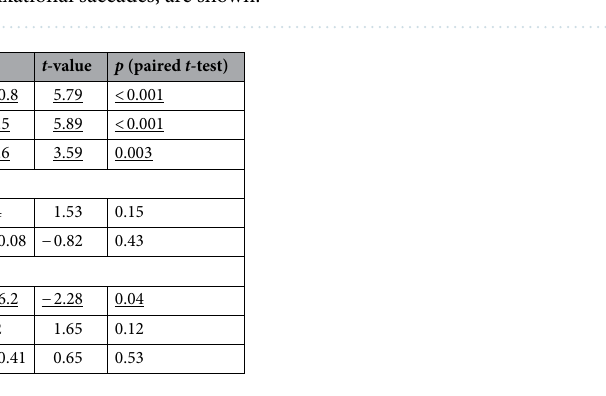
Figure 1. Traces of visually guided saccade, anti-saccade, and fixational saccade. Traces during baseline (top, a – c ) and rTMS (bottom, d – f ) conditions in a single patient are shown. Black downward deflected lines for visually guided and upward deflected lines for anti-saccade traces indicate successful saccade. Red downward deflected lines for anti-saccade traces indicate erroneous saccades toward a visual target. ( c , f ) Typical example traces during fixation, including small fixational saccades, are shown.